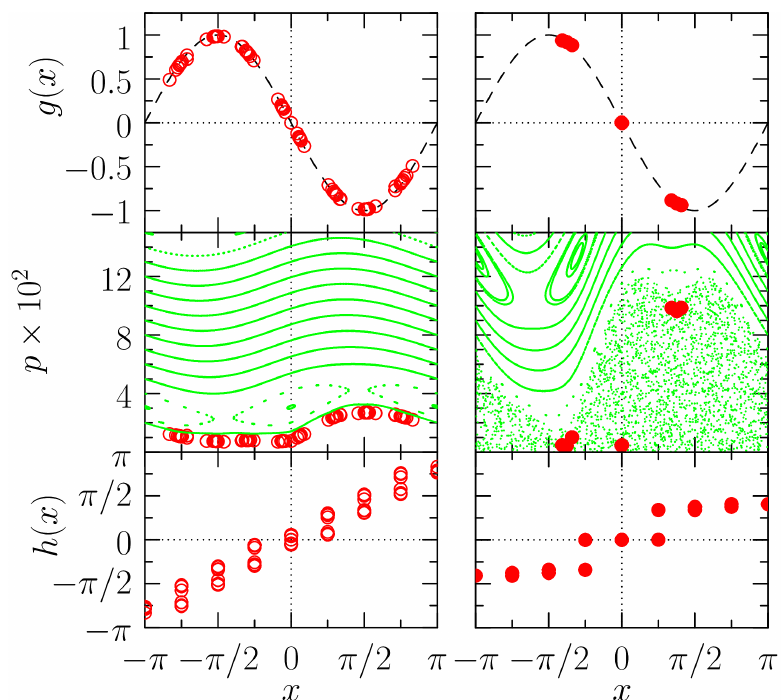
Figure 1. Functions related to the dynamical map obtained from the ground state equilibrium positions x 1 , . . . , x N of the atoms at K = 0.02 ( left column) and K = 0.1 ( right column). Top row: the red { } x 1 , . . . , x N circles show the reconstructed kick function g ( x ) using the the ground state positions . { } The dashed curved gives the theoretical form of the kick function g ( x ) = sin x . Middle row: phase − space portrait of the ( x , p ) -map (2) (green points) and the actual ground state positions of the atoms (red π circles). Bottom row: the atom positions are shown via the hull function h ( x ) = ( x i + π )[ mod 2 π ] − π ; the positions of the two atoms at the chain ends are fixed. versus x = ( 2 π ( i 1 ) / ν + π )[ mod 2 π ] − − Here we have N = 89 atoms and L = 55 periods, ν = 89/55.